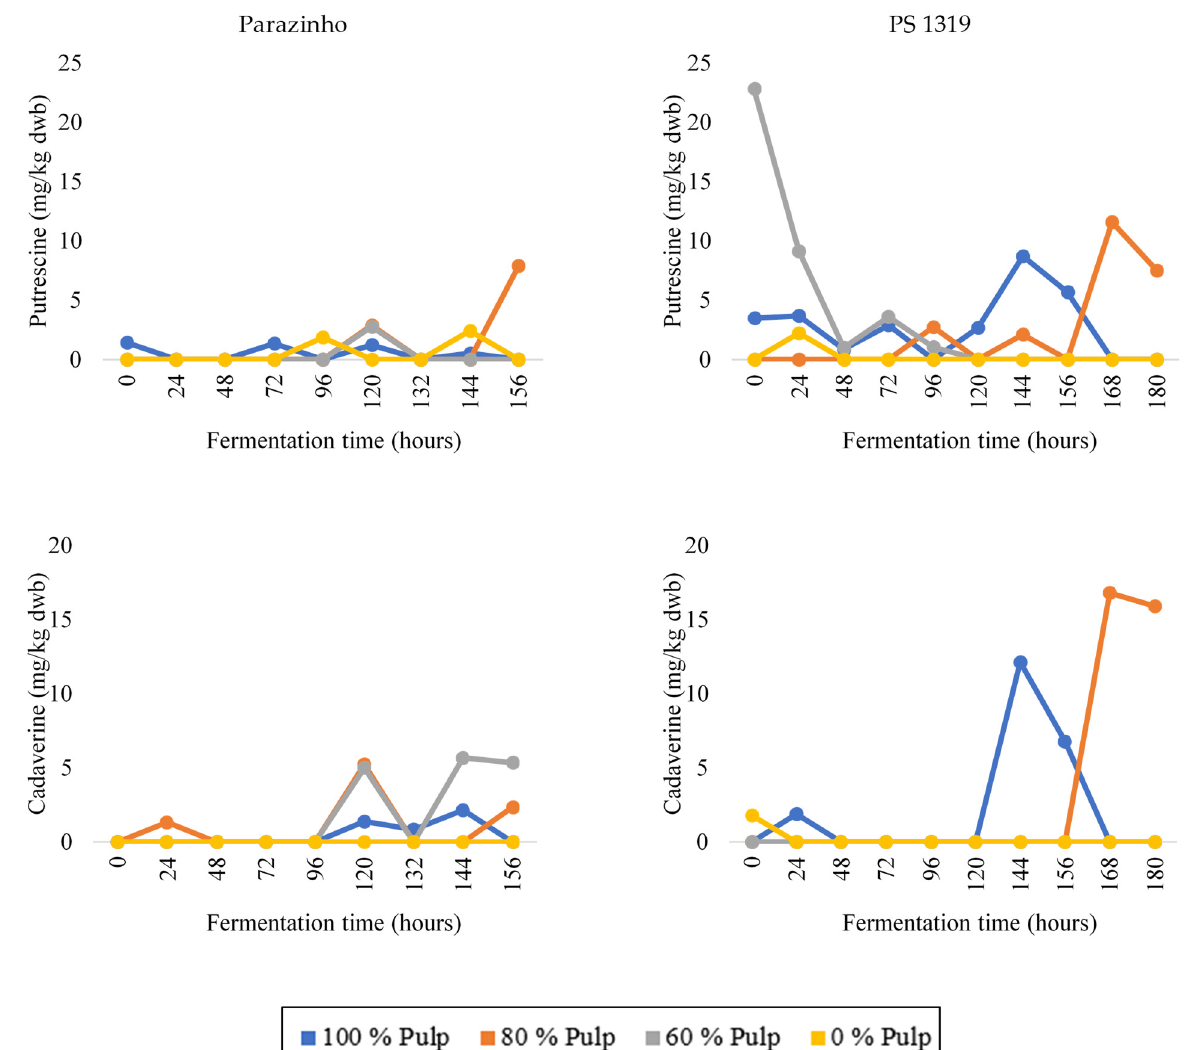
Figure 2. Changes in the levels of putrescine and cadaverine during on-farm fermentation of two varieties of cocoa (PS 1319 and Parazinho) from Bahia, Brazil, using different proportions of pulp (100, 80, 60, and 0%).